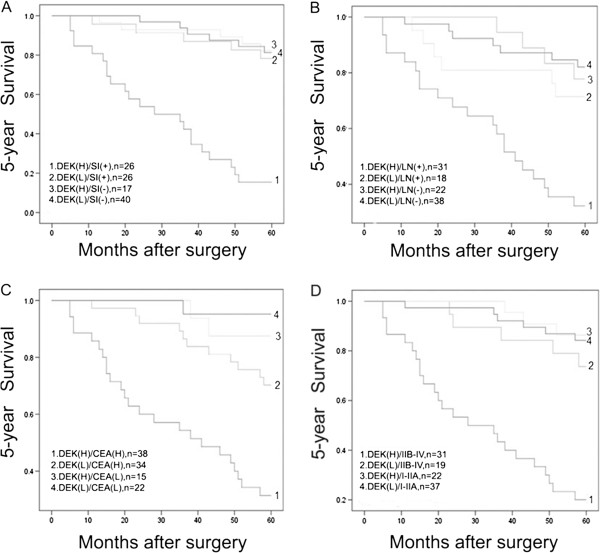
Kaplan-Meier analysis of 5-year survival rates in 109 patients with or without DEK highly expressed colorectal cancer in relation to serosal invasion (SI), lymph node (LN) metastasis, CEA level, and tumor stage. (A) Colorectal cancer with serosal invasion concomitant with DEK expression had a significantly lower 5-year survival rate than that without DEK expression (P<0.0001). (B) Colorectal cancer with lymph node metastasis and high DEK expression, had a significantly lower 5-year survival rate than colorectal cancer with lymph node metastasis in the absence of DEK expression (P=0.001). (C) Colorectal cancer patients with high CEA levels concomitant with high DEK expression had lower 5-year survival rates than those without DEK expression (P<0.0001). (D) Late-stage colorectal cancers concomitant with high DEK expression had the lowest 5-year survival rate, which was significantly lower than those without high DEK expression (P=0.004). (H, high; L, low).